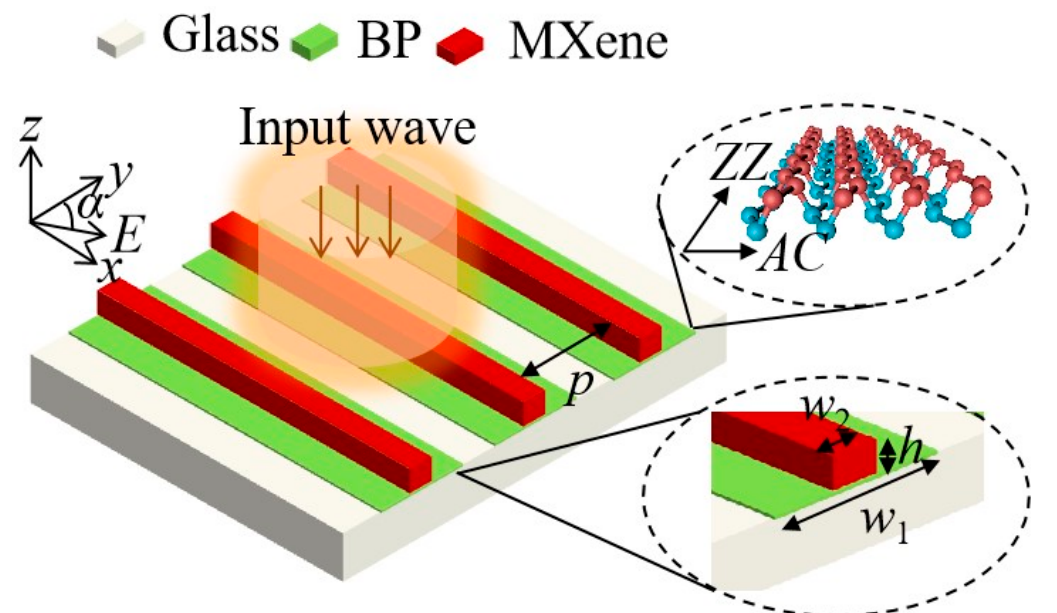
Figure 1. Schematic of the composite MXene/BP metasurface. Here, the transmission spectra for the proposed composite MXene/BP metasurface are discussed when h = 150 nm, w 1 = 250 nm, and w 2 = 200 nm, as shown in Figure 2a. We can see that an obvious transmission dip appears at the frequency of 9.75 THz, marked in a red line, when there is only the BP layer on the surface of SiO 2 . Then, the electric field E B is studied at the frequency of 9.75 THz when there is only the BP layer on the surface of SiO 2 , as shown in Figure 2b. From Figure 2b, we can clearly see that the SPs on the surface of the BP layer are strongly excited. Therefore, the transmission dip at the frequency of 9.75 THz is caused by the strongly excited SPs on the surface of the BP layer. The black solid line shows the transmission spectra when there is only an MXene nano-rod on the surface of the SiO 2 substrate. A transmission dip with a small quality factor occurs at the frequency of 32.54 THz, as depicted in Figure 2a. In order to further understand the physical mechanism of its generation, the electric field E M , at the frequency of 32.54 THz, is plotted in the Figure 2c. As shown in Figure 2c, strong SPs are excited on the four edges of the MXene material, and the SPs on the two edges close to the substrate are significantly stronger than those on the two edges far from the substrate. Thus, the transmission dip with the smaller quality factors is caused by the strong radiating SPs on the four edges of the MXene material, as shown in Figure 2a. At last, the blue line describes the transmission spectrum for the proposed composite MXene/BP metasurface. An obvious Fano resonance-like spectrum, caused by coupling between the mentioned two SPs modes, can be seen for the composite MXene/BP metasurface, as shown in Figure 2a. The electric field E M-B , at the frequency of 25.34 THz, for the Fano resonance-like peak is also studied in Figure 2d. Compared with the electric field in Figure 2b,c, we can see that the electric field E M-B shows strong enhancement at the interface of the MXene material and the BP layer. The strong enhancement for the electric field E M-B is caused by the strong coupling between the SPs on the BP layer and SPs on the two edges close to the substrate. Thus, the proposed composite MXene/BP metasurface can realize the Fano resonance-like spectra and obvious electric field enhancement. The findings about the Fano resonance-like spectra and electric field enhancement may be instructive for the design of plasmonic